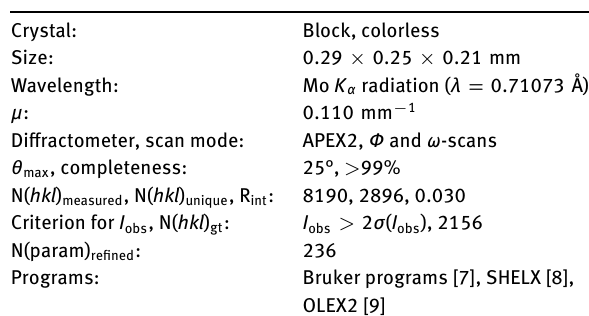
Table 1: Crystal collection and